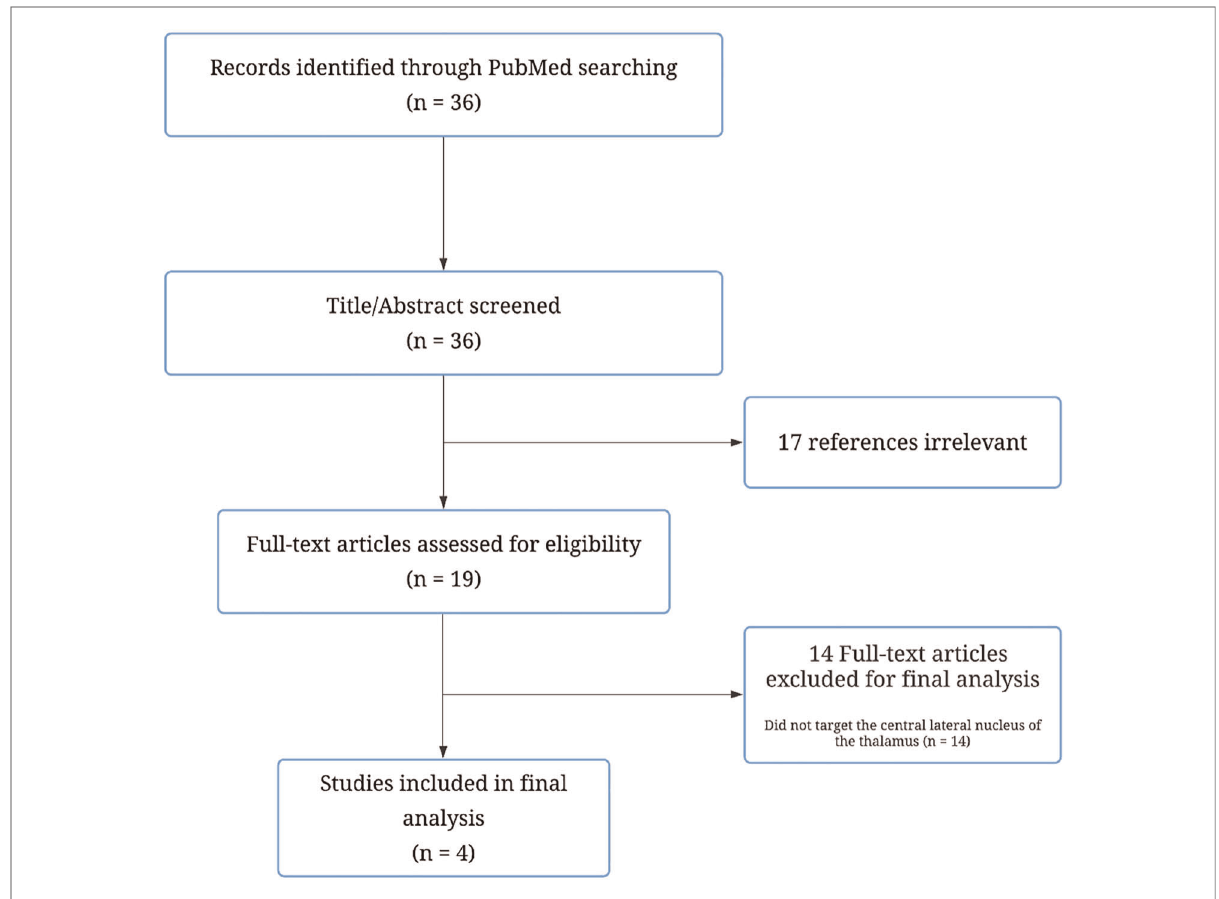
FIGURE 1 Flowchart depicting study selection process for fi nal